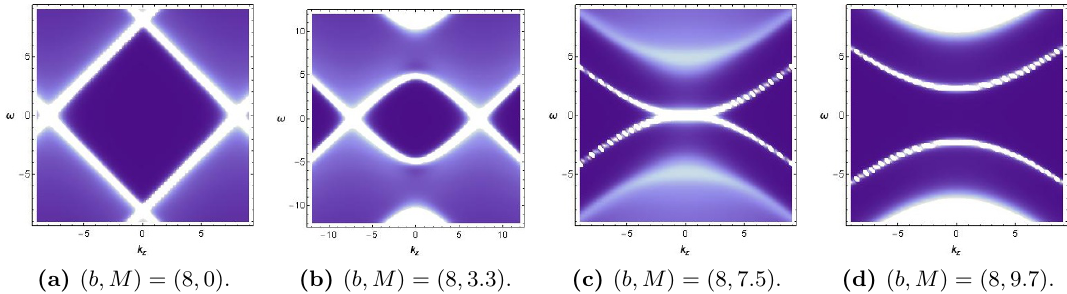
Figure 4. (a)-(d): spectral densities on ( k z ; ! )-space with k x = k y = 0 at T = 2 =(cid:25) . Separation between the Weyl points is approximately 2